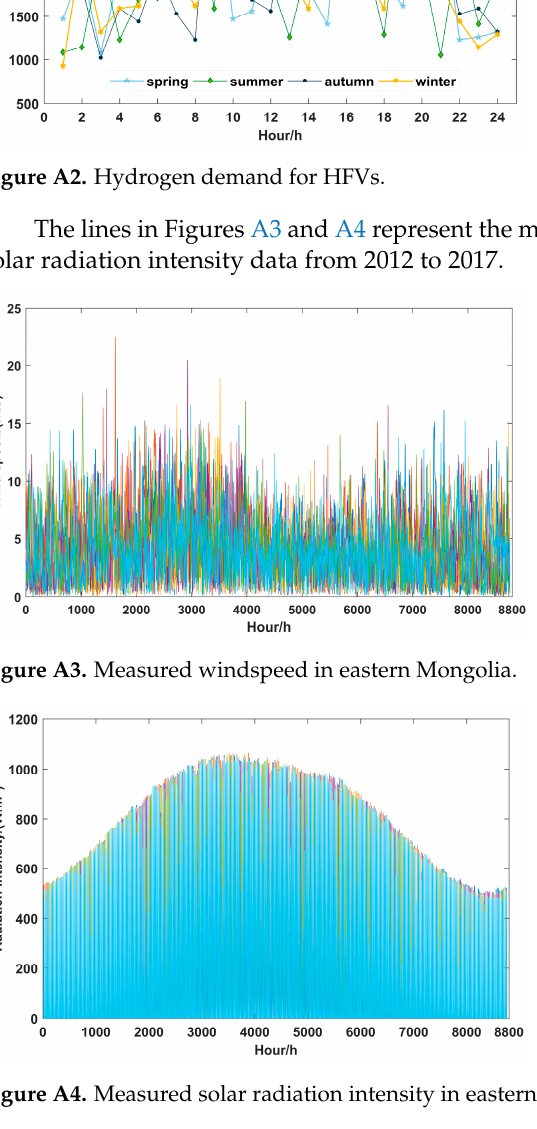
20 Table A2. HRS parameters.